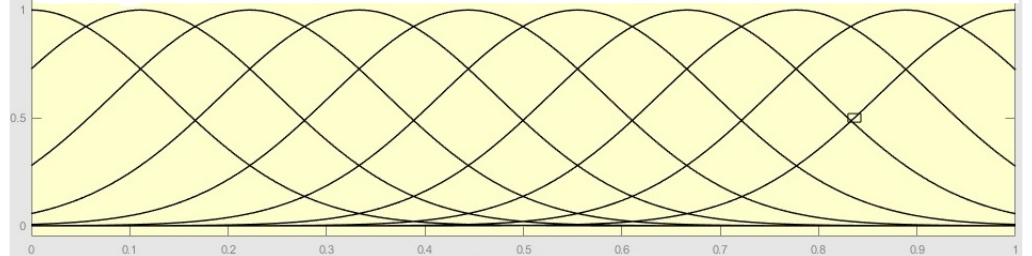
Figure 1. Aggregation function of the membership functions of the linguistic variables of the ex- perts.